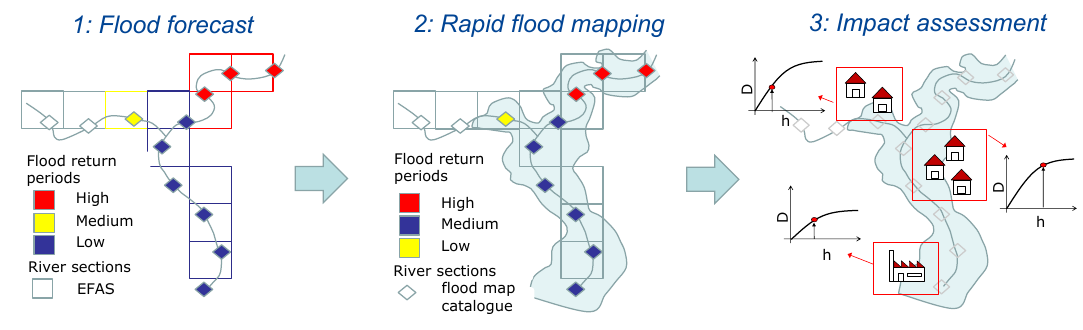
Figure 1. Conceptual scheme of the rapid risk assessment procedure.